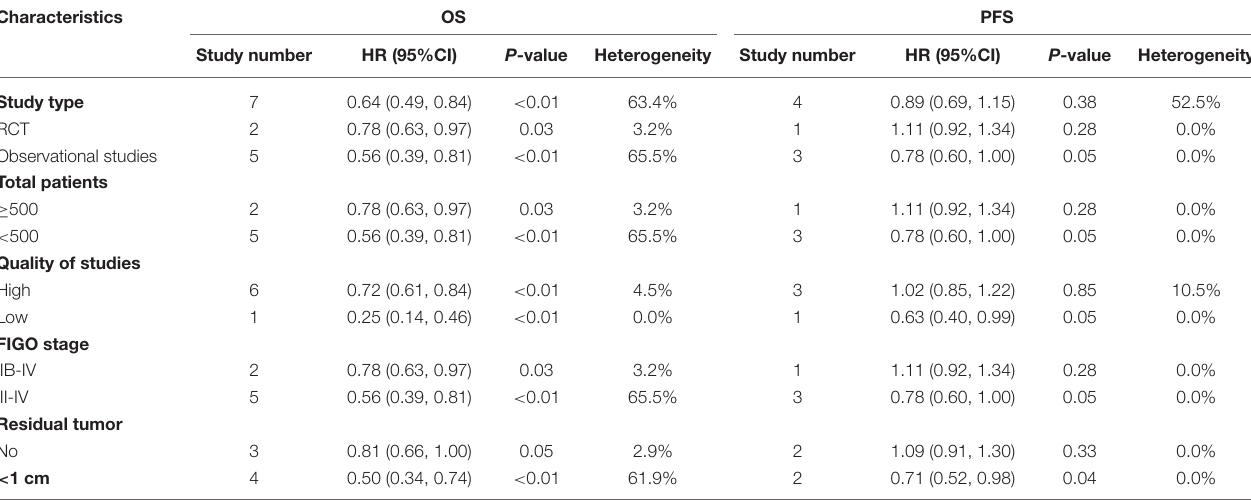
TABLE 2 | Subgroup analyses of systematic lymphadenectomy and survival outcomes in patients with advanced ovarian cancer. Characteristics